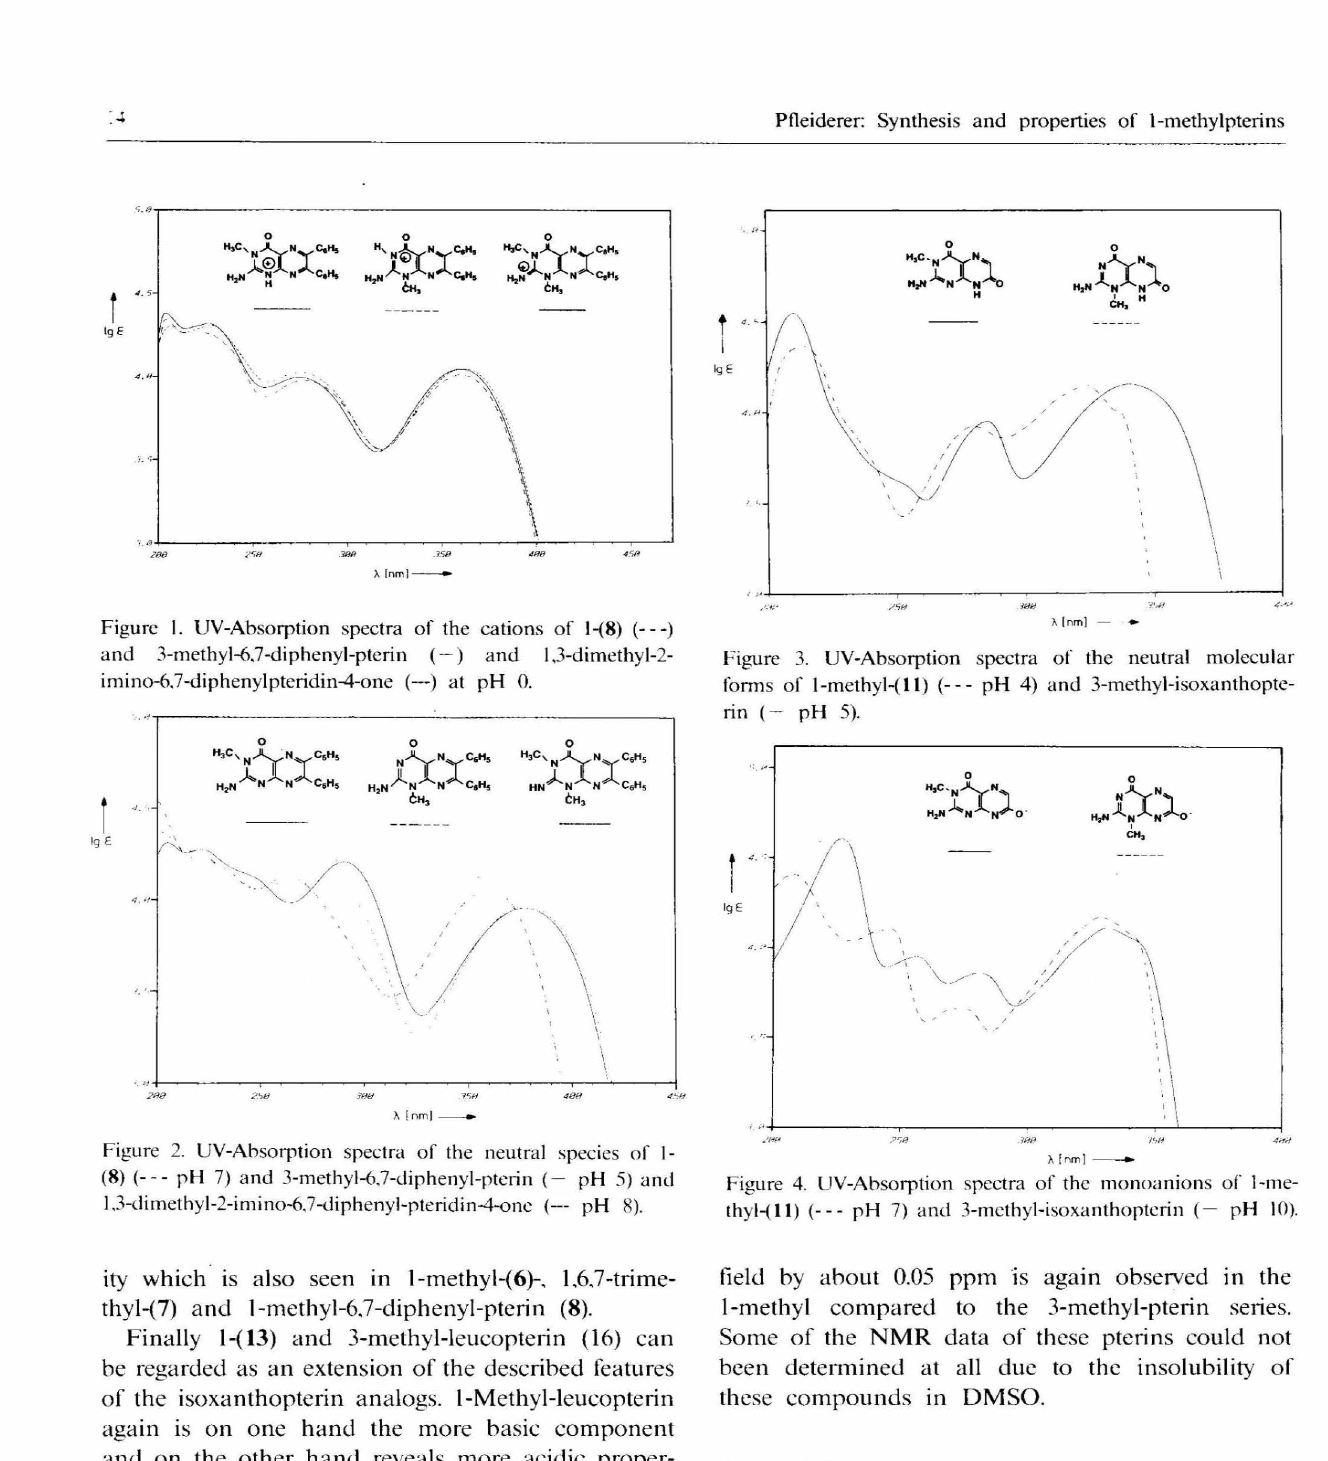
Figure 2. UV-Ahsorption spectra of the neutral species of 1- (8) (- - - pH 7) and 3-methyl-6.7-diphenyl-pterin (- pH 5) and lJ-dimethyl-2-imino-6,7-diphenyl-pteridin-4-one (-- pH 8).